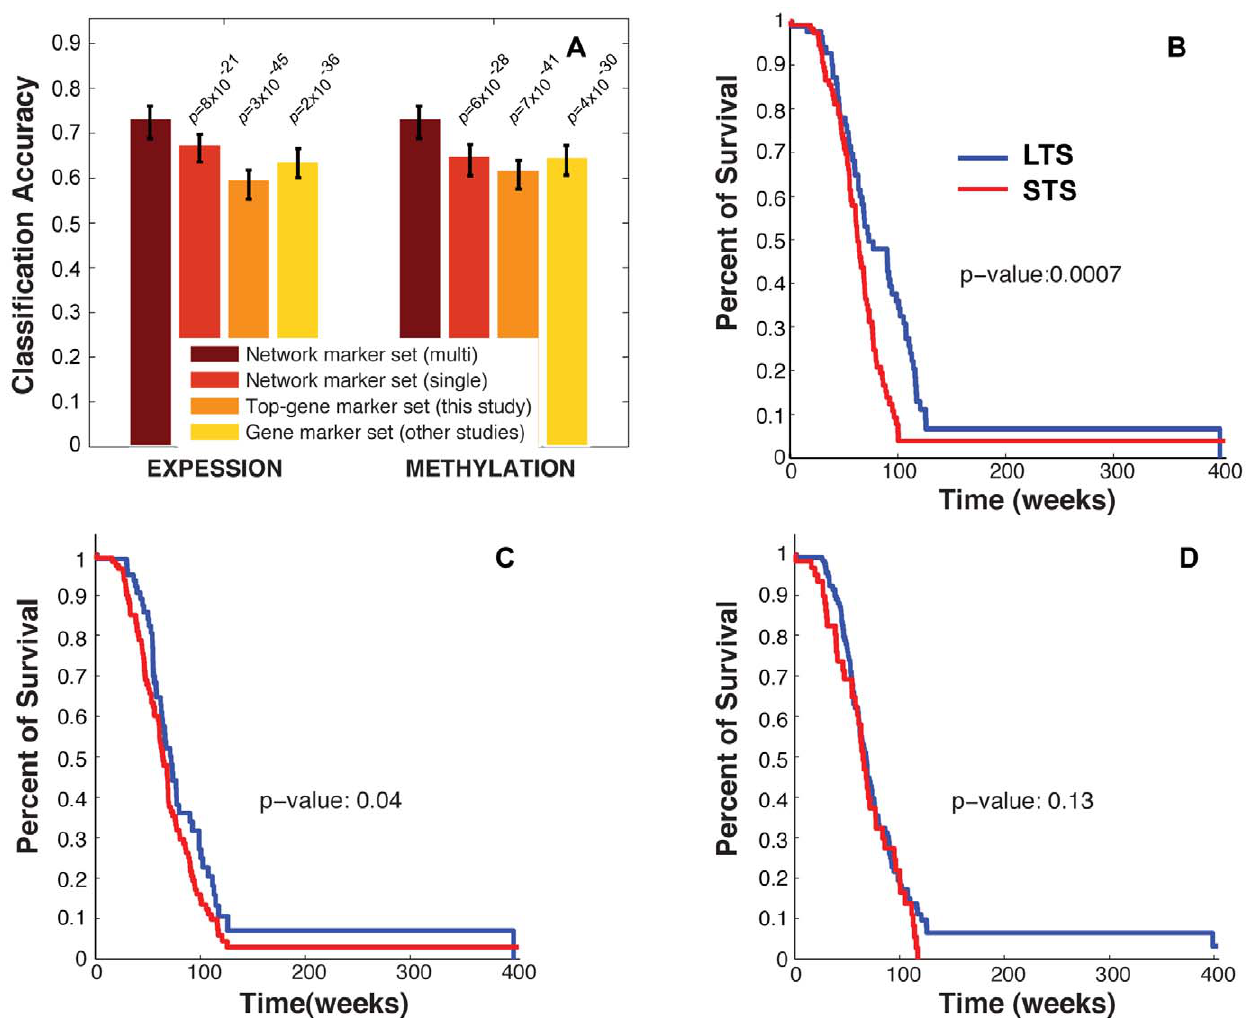
Figure 4. Performance of multi-analyte modules for GBM patient prognosis. A ) Prognostic accuracies of GBM patients by four marker sets. Expression data of 42 GBM patient was used to derive the module set. Two hundred thirty seven additional GBM patients from TCGA were used for classification using the module set. Support Vector Machine algorithm was used to build a classifier based on each marker set. Top-gene sets were size-matched to the network module sets (i.e., the same number of genes as in the network module sets). Error bar is the standard deviation based on 100 leave-one-out cross validations. P-values are based on t-tests comparing the average classification accuracy of the multi-analyte-module-based classifier to those of other classifiers. B–D ) Kaplan-Meier survival curves for LTS and STS GBM patients classified using the combined module set (B), 38-gene set (C), and G-CIMP + set (D). P-value indicates the significance of separation between the two curves and is computed using logrank test.